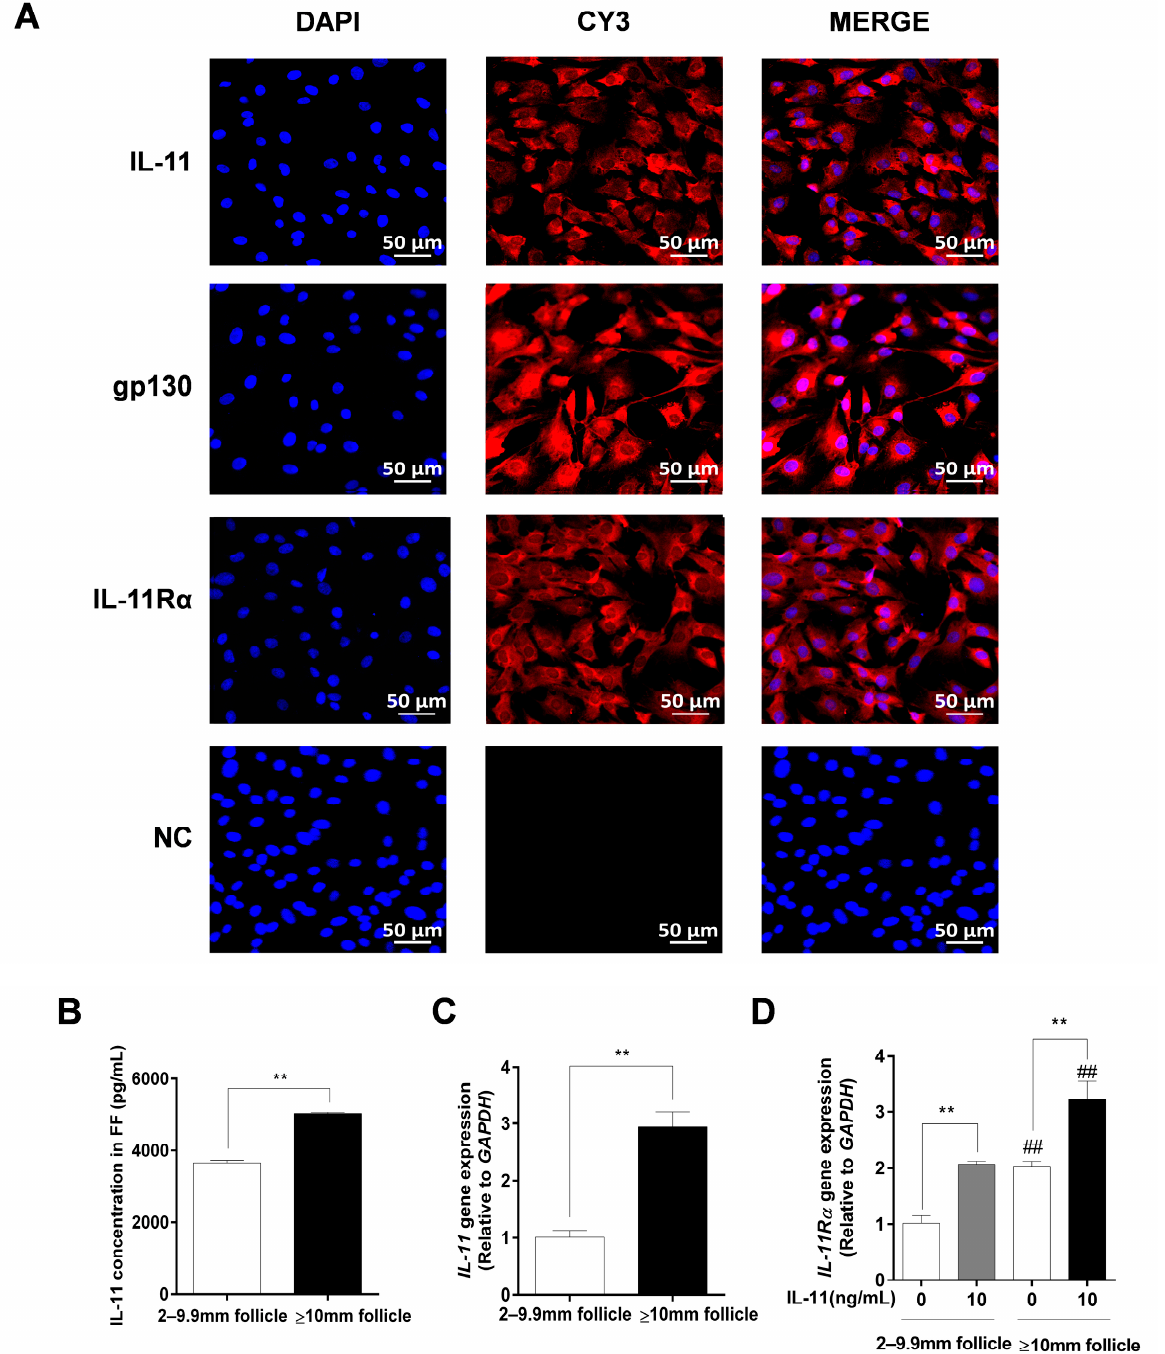
Figure 3. The subcellular localization and expression of the IL-11 system in bovine GCs. ( A ) Cells were stained with specific antibodies against IL-11 (red), gp130 (red), and IL-11R α (red), and the nucleus was stained with DAPI (blue). The specific signals were examined using indirect immunofluorescence and confocal microscopy. The scale bar represents 50 µ m. ( B ) The concentrations of IL-11 in different diameter follicles were measured by ELISA. ( C ) The relative mRNA expression levels of IL-11 were determined in GCs from different diameter follicles by qRT-PCR and normalized by GAPDH. ( D ) The relative mRNA expression levels of IL-11 R α were detected in GCs from different diameter follicles in the absence or presence of IL-11 by qRT-PCR and normalized by GAPDH. ** p < 0.01 between the indicated groups. ## p < 0.01 between the control groups or the IL-11 treatment